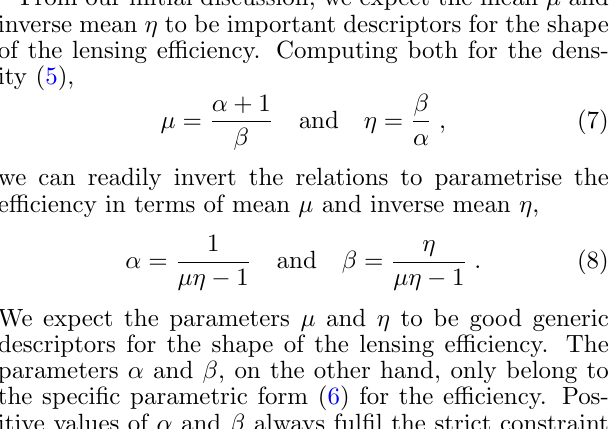
Figure 1. Distinct source distance distributions ( top ) with visu- ally (and cosmologically, see Section 3) similar lensing efficien- cies ( bottom ). The total area under the curve q ( x ) is µ/ 2, whereas it would be the shaded area η − 1 / 2 for a curve with fixed slope. is also constrained by the mean comoving distance µ . For